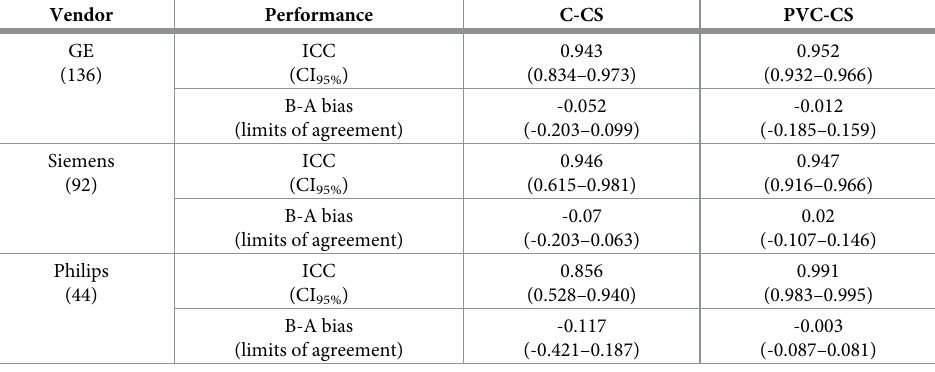
Table 6. ICC with 95% confidence interval and Bland-Altman with bias and limits of agreemnts of the CAC vol- umes over three different vendors (GE, Siemens, Philips) calculated for C-CS and PVC-CS.